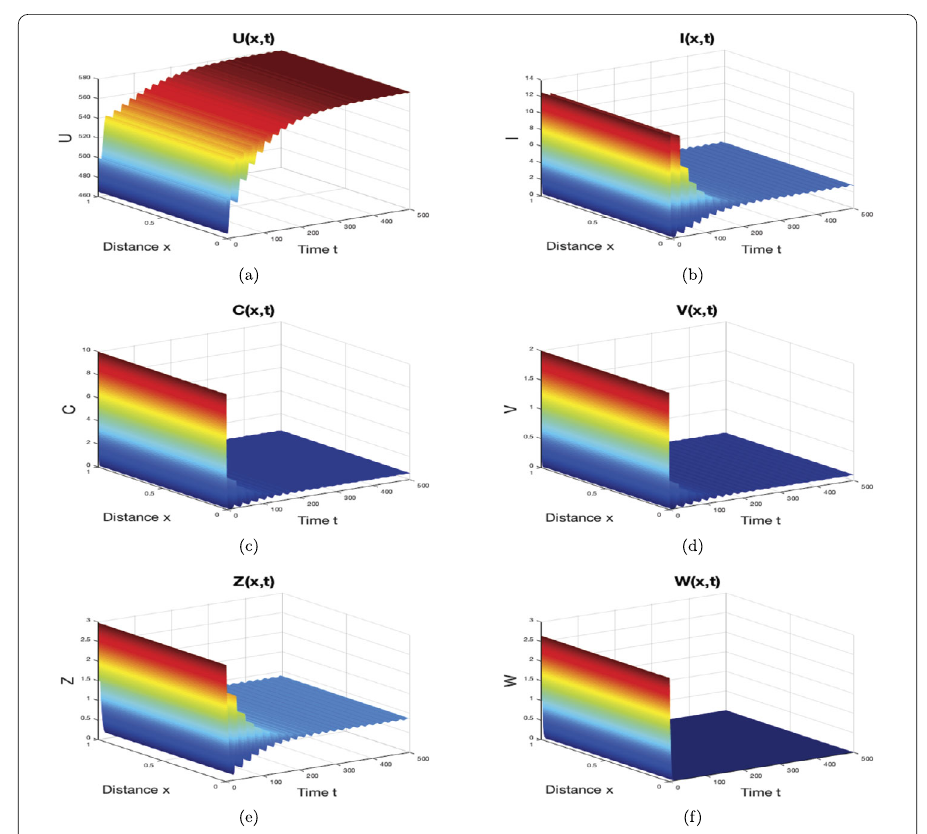
≤ 1. The infection equilibrium R 3